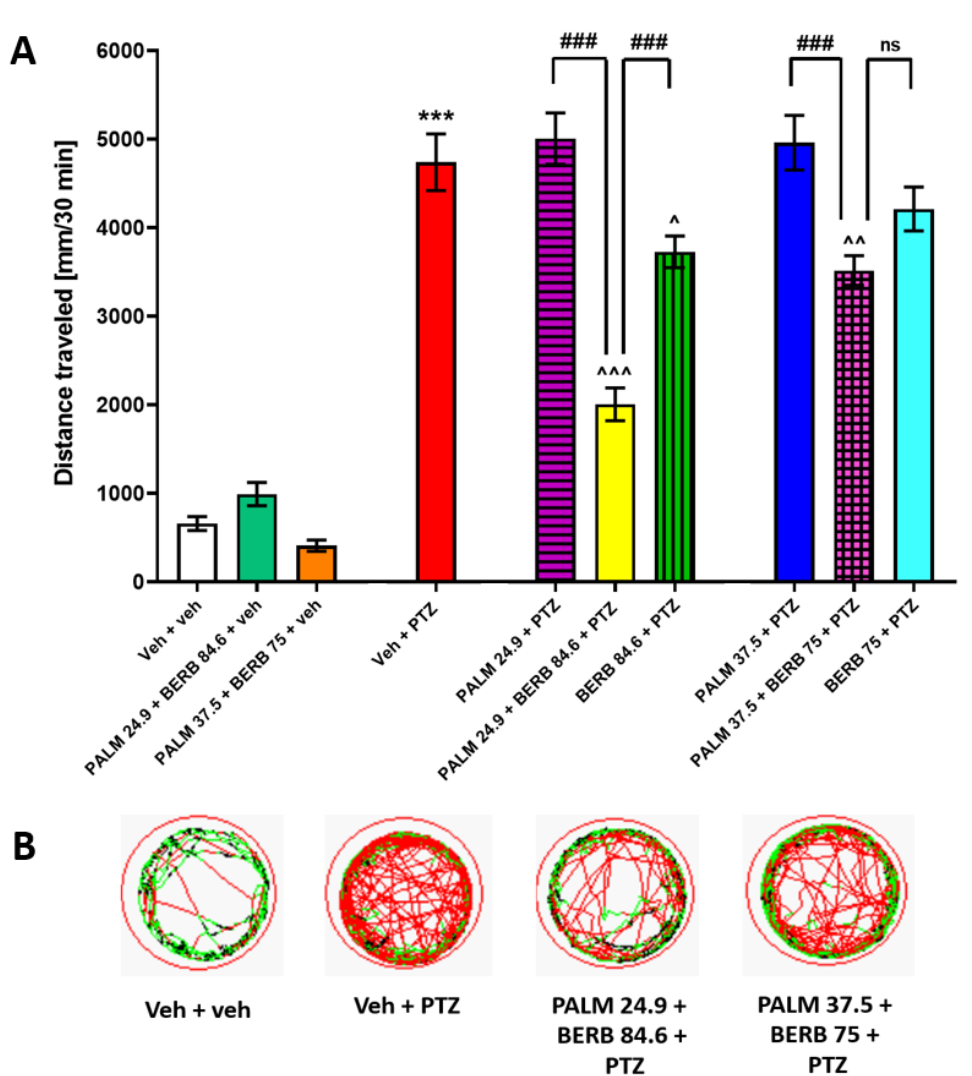
Figure 8. The influence of an artificially created combination of PALM and BERB on the seizure-like behavior in the zebrafish PTZ-induced hyperlocomotion assay. In the first set of experiments, alkaloids were used in doses equal to their ED 16 values: PALM (24.9 µ M), BERB (84.6 µ M). In the second set of experiments, alkaloids were used at sube ff ective doses: PALM (37.5 µ M) and BERB (75 µ M). Zebrafish larvae after 24 h preincubation with investigated compounds alone or in combination were exposed to 20 mM PTZ. Seizure-like behavior was assessed 5 min after acute PTZ exposure. Results of the assay are presented as ( A ) total distance traveled during 30 min of assay, and ( B ) digital tracking map of larvae at second (5–10 min) interval of experiment: large movement—red, small movement—green. Data were analyzed using one-way ANOVA, followed by the Tukey’s post-hoc test. Data are depicted as a mean ± SEM. Veh + veh ( n = 32), PALM 24.9 + BERB 84.6 + veh ( n = 34), PALM 37.5 + BERB 75 + veh ( n = 24), Veh + PTZ ( n = 31), PALM 24.9 + PTZ ( n = 31), PALM 24.9 + BERB 84.6 + PTZ ( n = 39), BERB 84.6 + PTZ ( n = 32), PALM 37.5 + PTZ ( n = 39), PALM 37.5 + BERB 75 + PTZ ( n = 48),